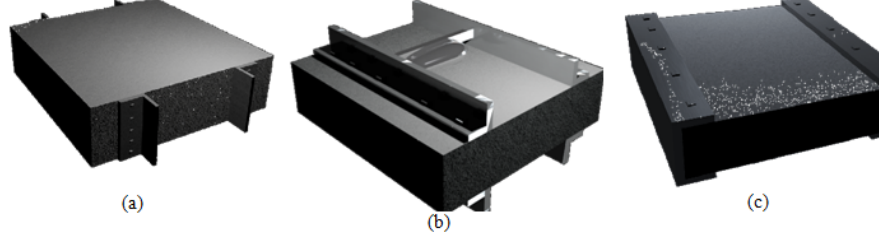
Figure 24: Application of the load for the tensile test